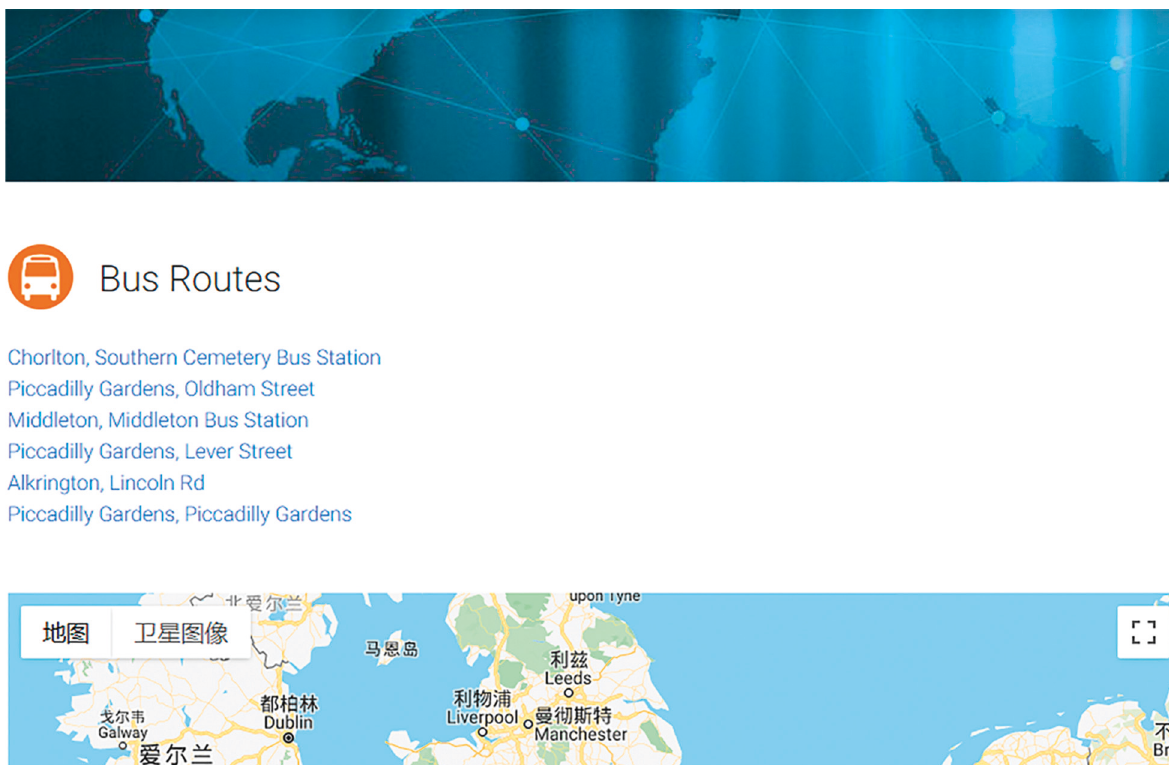
Figure 9: The bus route list through Solid.